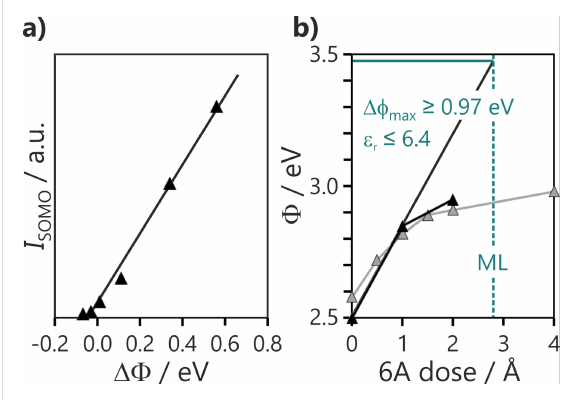
Figure 6: (a) Relation between integrated SOMO intensity and work function change induced by molecule adsorption on MgO(100)/Ag(100) ( ΔΦ ) after tuning Φ MgO to slightly different values. (b) Work function versus 6P dose for two different initial work functions. The dose corre- sponding to a full ML is indicated by the dashed